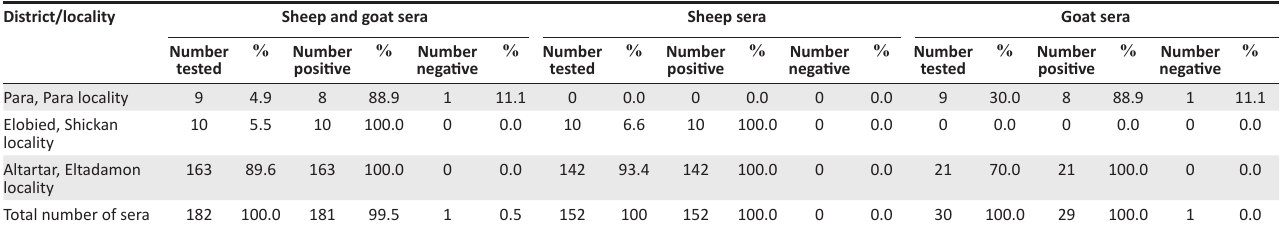
TABLE 6: Seroprevalence of peste des petits ruminants virus antibodies in sheep and goat sera within districts and localities of Kordofan States. District/locality Sheep and goat sera Sheep sera Goat